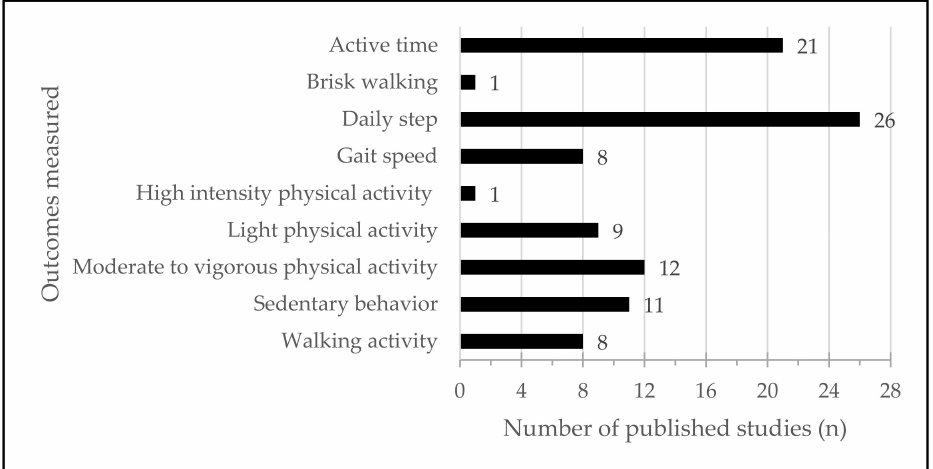
Figure 5. Outcomes measured in included studies ( n